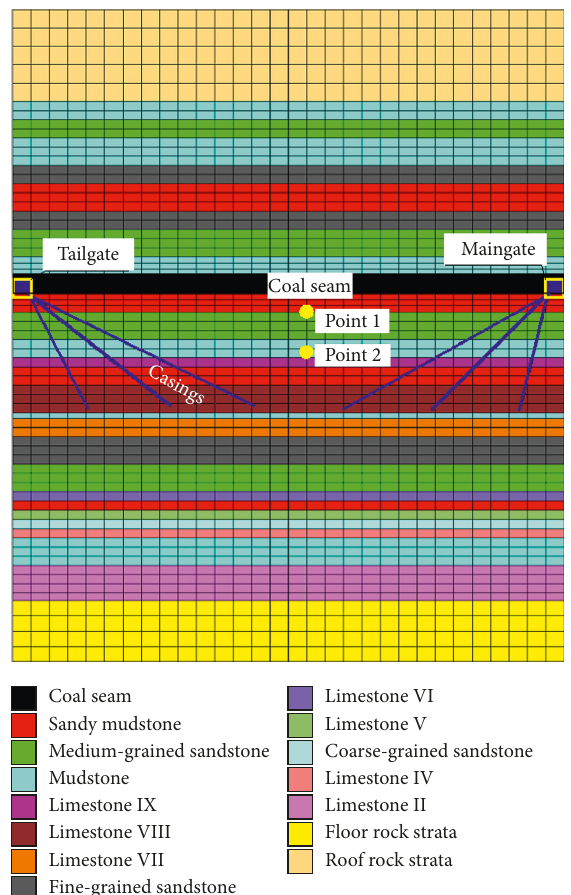
Figure 12: Numerical model